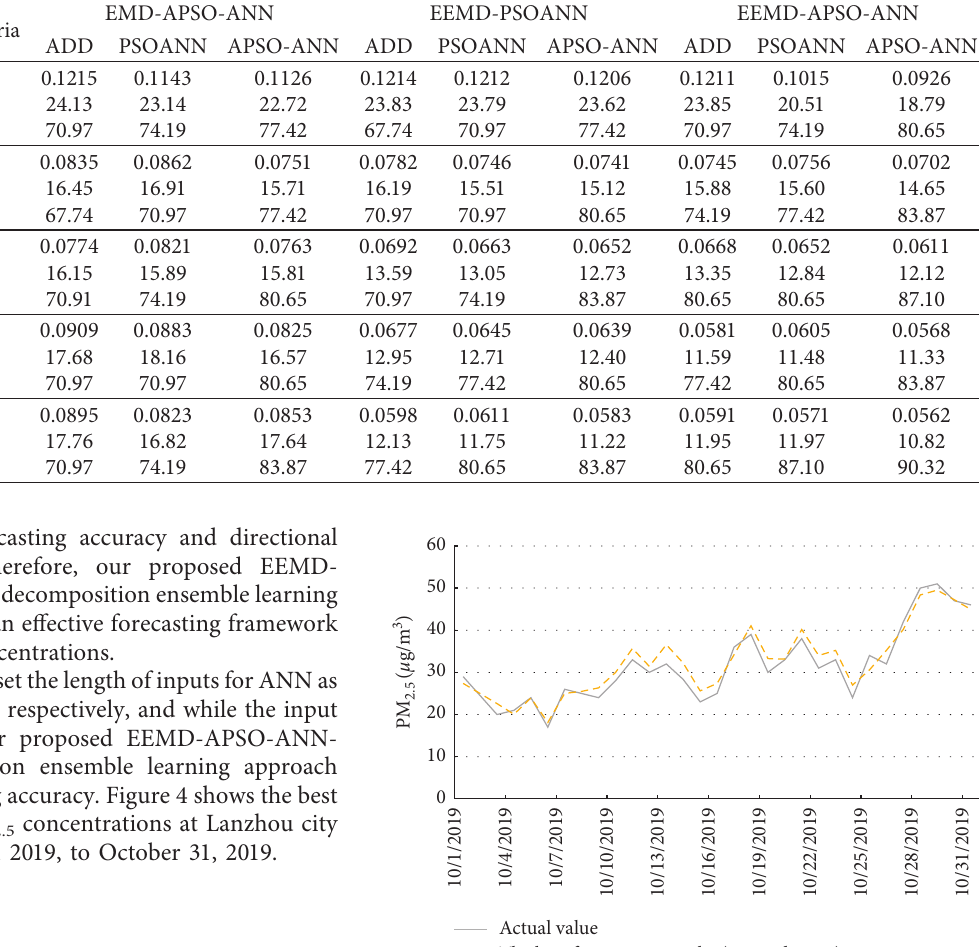
Table 3: The forecasting results of different decomposition ensemble approaches. Lag order Evaluation criteria